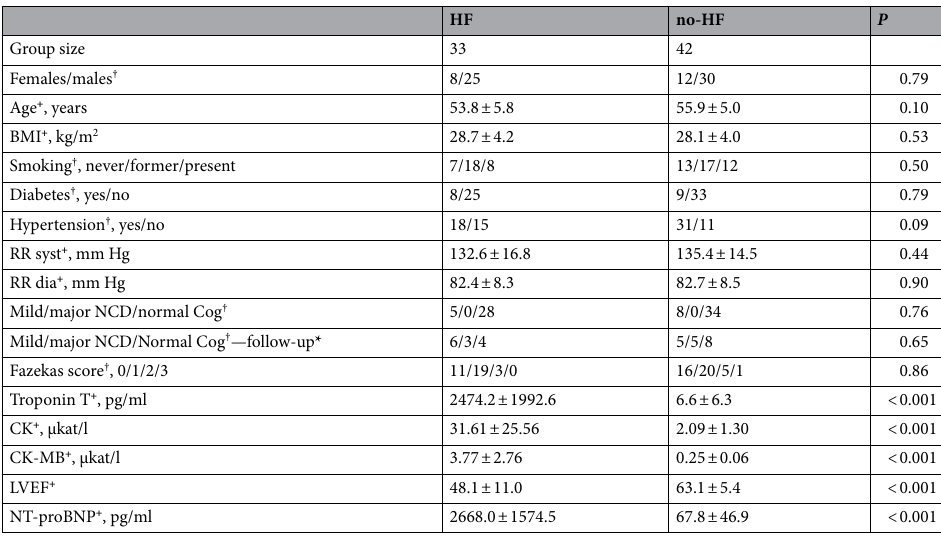
Table 1. Demographic and clinical data of the studied subgroups. HF: heart failure; no-HF: group patients without heart failure; BMI: body mass index; RR syst: systolic blood pressure; RR dia: diastolic blood pressure; Mild/Major NCD: mild/major neurocognitive disorder; Normal Cog: cognitively normal; Troponin T: high sensitive troponin T; CK: creatine kinase; CK-MB: CK isoenzyme muscle brain; LVEF: left ventricular ejection fraction; NT-proBNP: N-terminal prohormone of brain natriuretic peptide; + two-sample t -test, two-sided, unequal variance; † Fisher’s exact test, two-sided. * Note that the follow-up investigation after approximately nine years could re-investigate the original cohort only